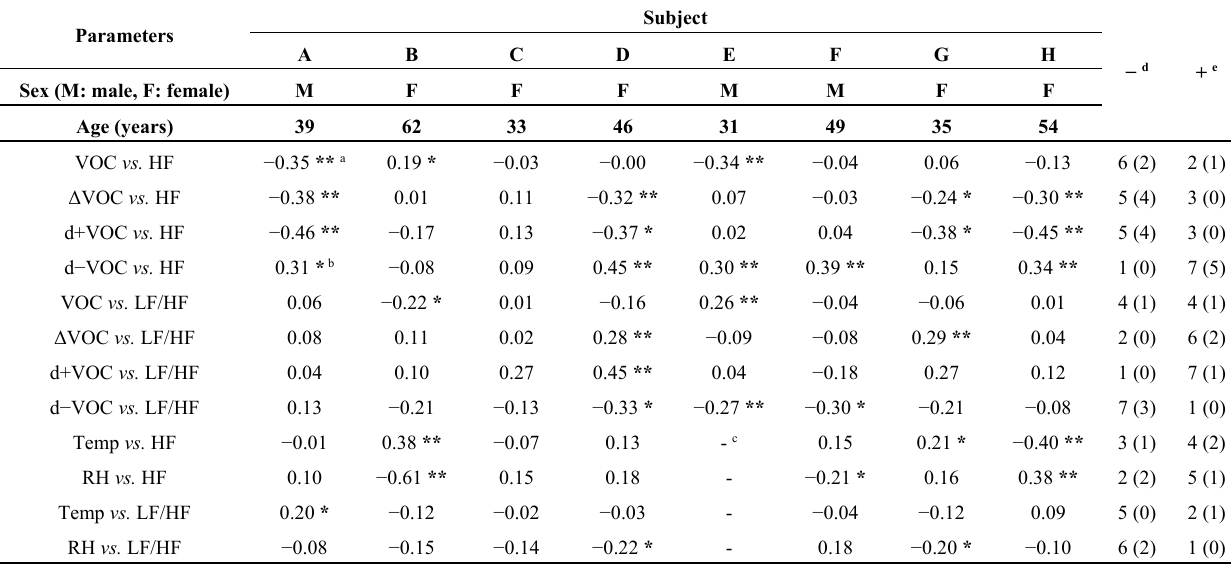
Table 2. Correlations between VOC exposure and HRV